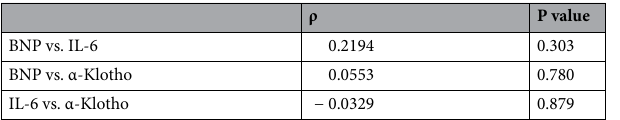
Table 2. Correlation between serum BNP, IL-6, and α-Klotho levels. Serum BNP, IL-6, and α-Klotho levels were measured on admission. Spearman’s correlation coefficient was used. BNP, brain natriuretic peptide; IL-6,